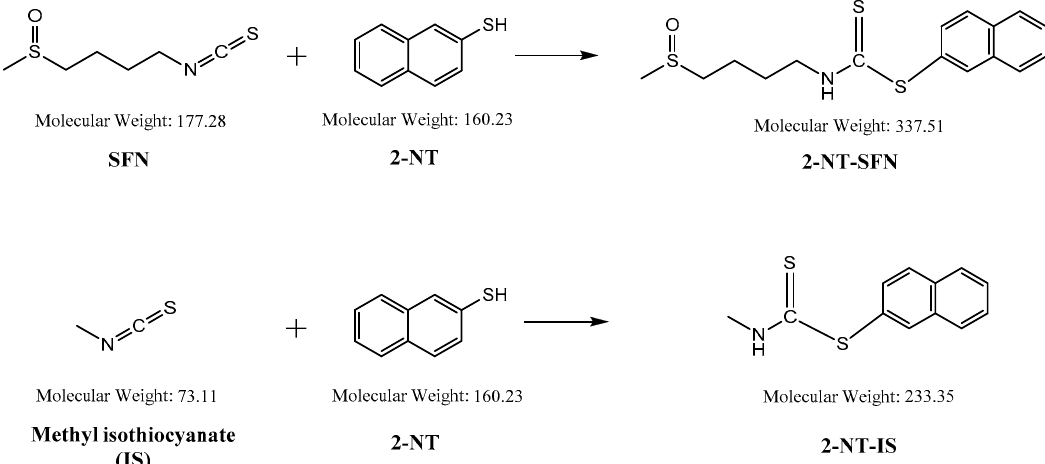
Figure 1. Chemical structures of sulforaphane (SFN) and methyl isothiocynate employed as an internal standard (IS), and their derivatives reacted with 2-naphthalenethiol (2-NT).